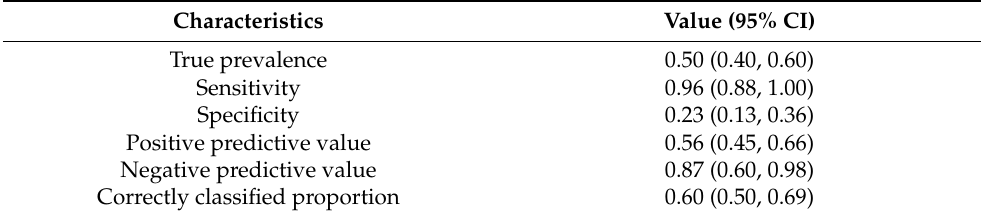
Table 4. STARD3 score performances on pCR prediction.